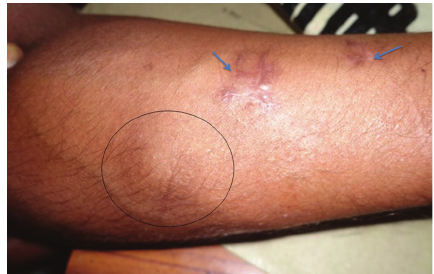
Figure 1: (Case 1): linear thickening of right superficial peroneal nerve.